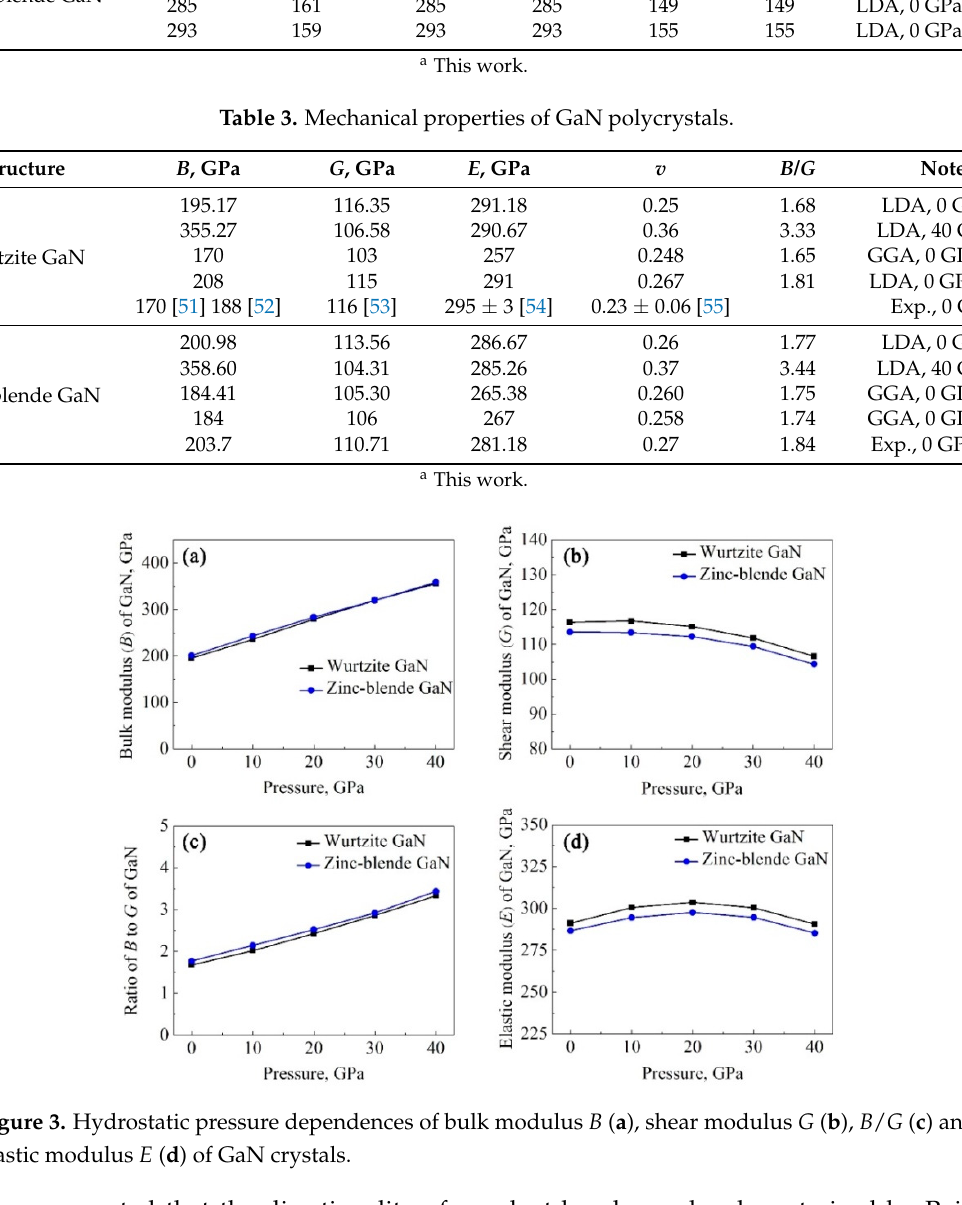
Table 2. Calculated elastic constant C ij (GPa) under pressures 0 and 40 GPa.